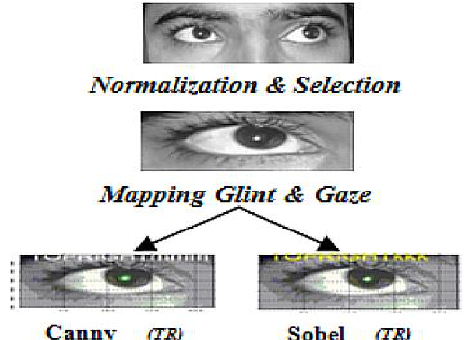
Figure 6: Estimating gaze